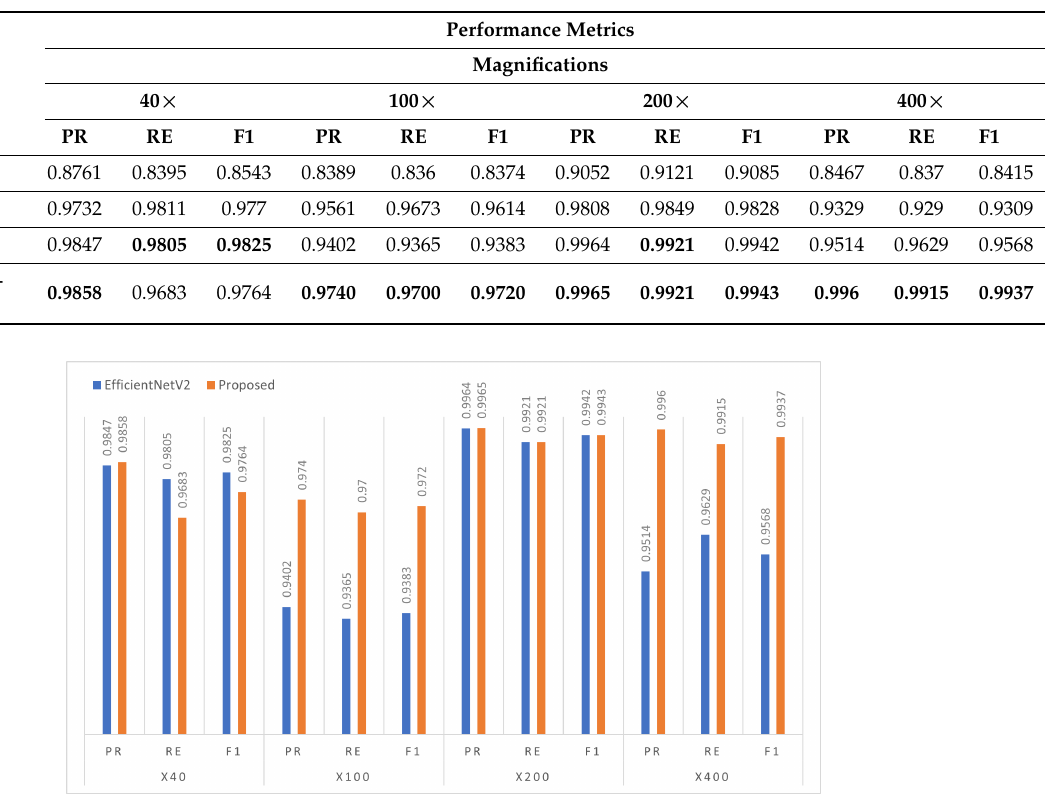
Figure 3. Illustration of the binary class classification performance achieved by the proposed model compared to the EfficientNetV2 network under multiple magnification